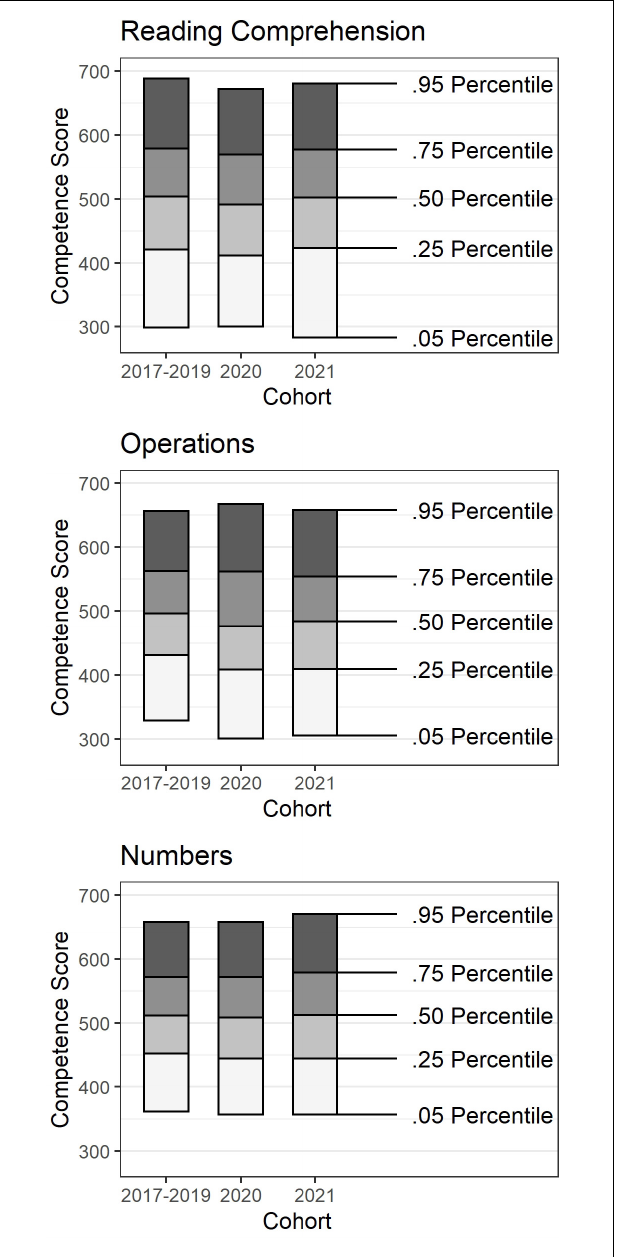
FIGURE 2 | Five Selected Percentiles for the Cohorts in the Years before the Pandemic (2017–2019), After the First Wave of the Pandemic (2020), and After the Third Wave of the Pandemic